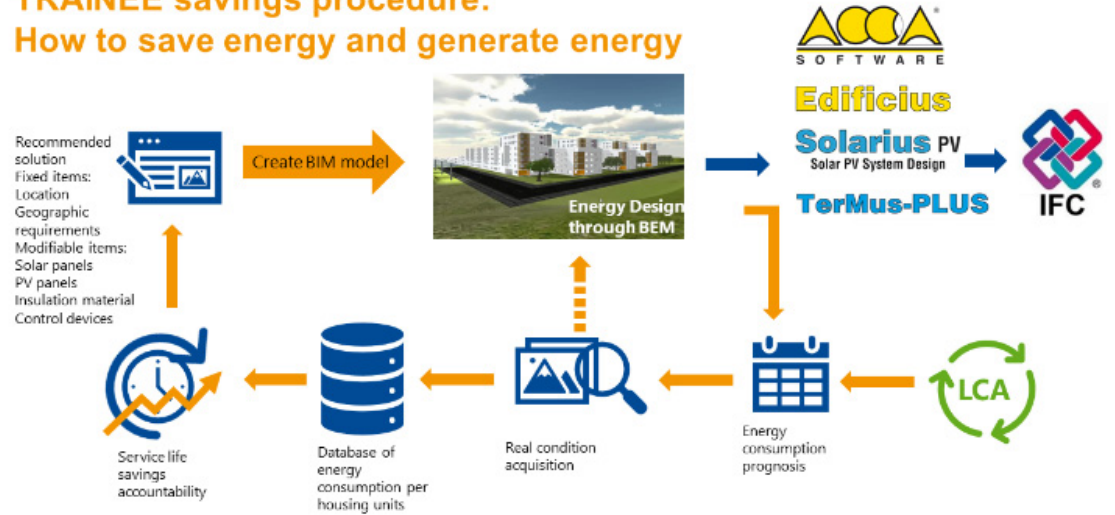
Figure 11. Digital procedure to implement BEM digital models in housing communities developed by TRAINEE project to track energy consumptions and savings.